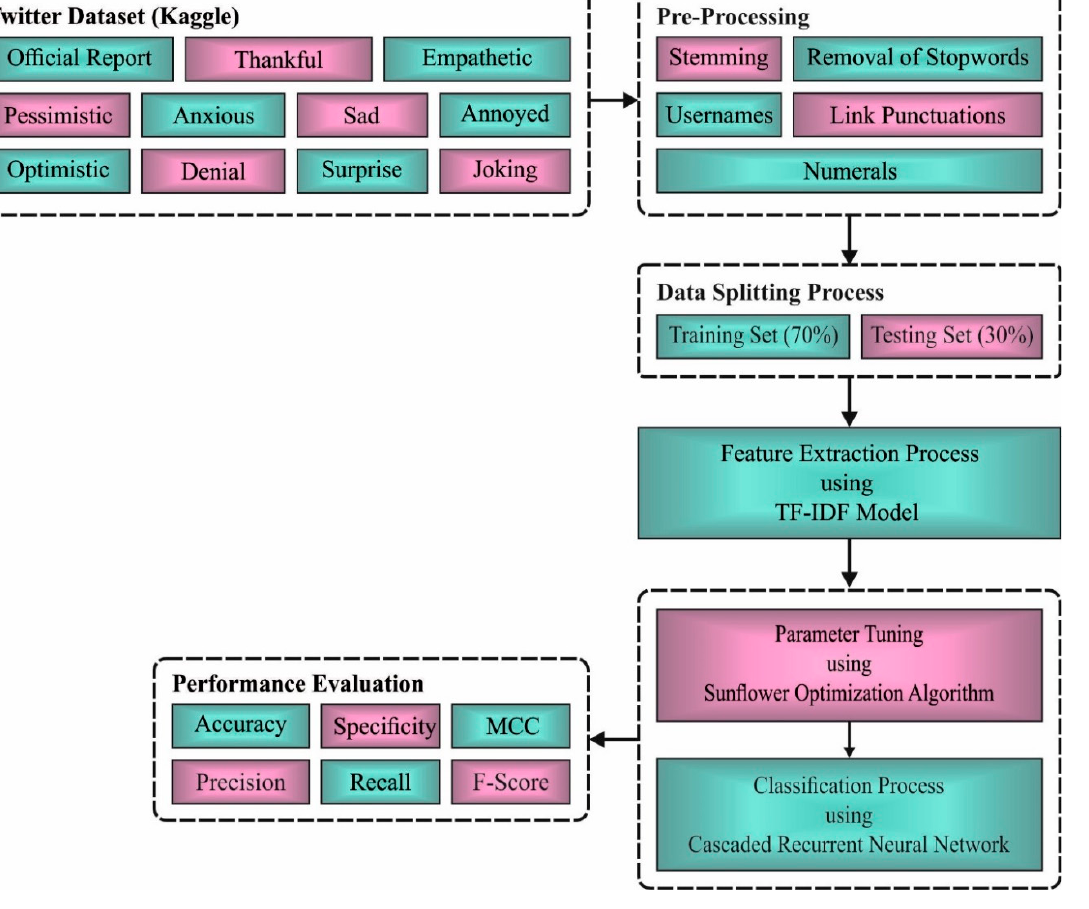
Figure 1. Overall process of SFODLD-SAC technique.